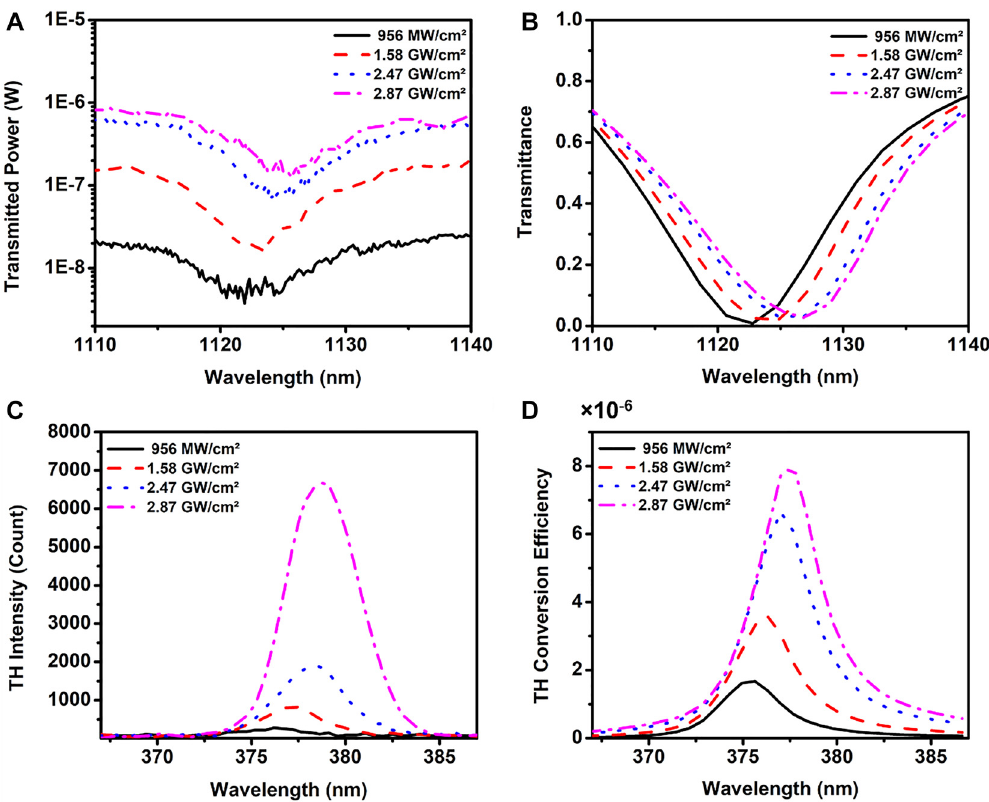
Figure 3: Measurement results of power-dependent Mie resonance position and THG. The experimental (A) and simulated (B) results of red shift of the Mie resonance dip with the increase of the intensity of the fundamental beam. The linear transmittance dip in Figure 2A is at 1119 nm and moves to 1122 nm when the pump laser with 956 MW/cm 2 is applied. After increasing the pump beam intensity further to 2.89 GW/cm 2 , the dip moves to 1126 nm. The transmitted power is measured by the pumping at wavelength of 1128 nm with the femtosecond laser. The measured (C) and simulated (D) shift of THG with the increase of the intensity of the fundamental beam. The THG efficiency is calculated by the THG power divided by the fundamental beam